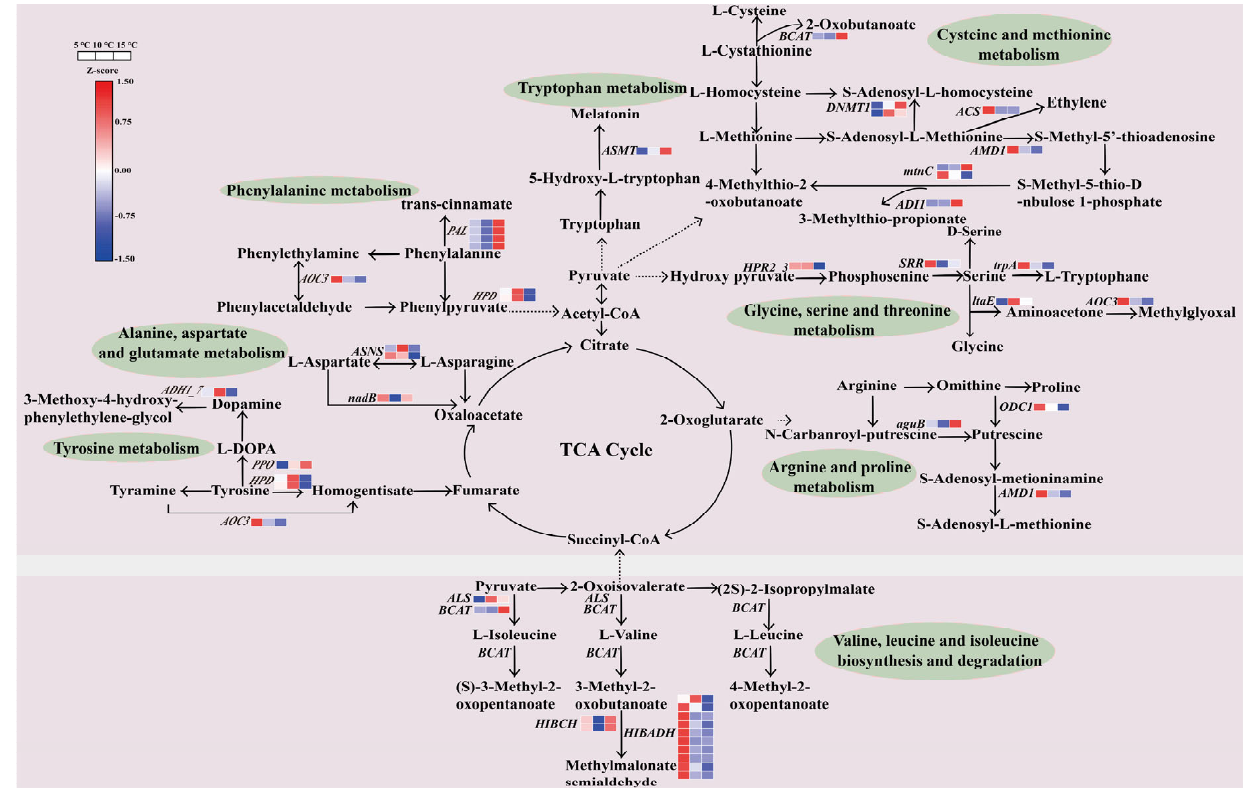
Figure 8. The expression patterns of genes in amino acid metabolism in the 5 °C, 10 °C, and 15 °C DIF treatments.